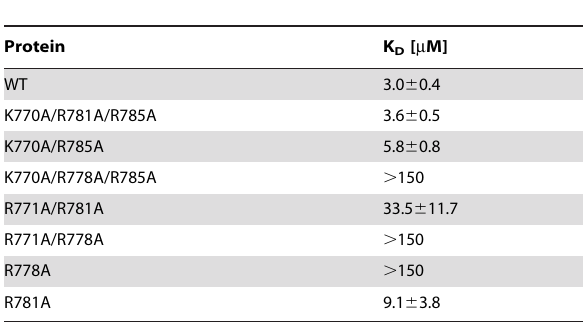
Table 1. Analysis of the effects of charge-neutralizing mutations within the TRPV1-CT distal region (712–838) fusion protein on equilibrium dissociation constants determined by surface plasmon resonance experiments.